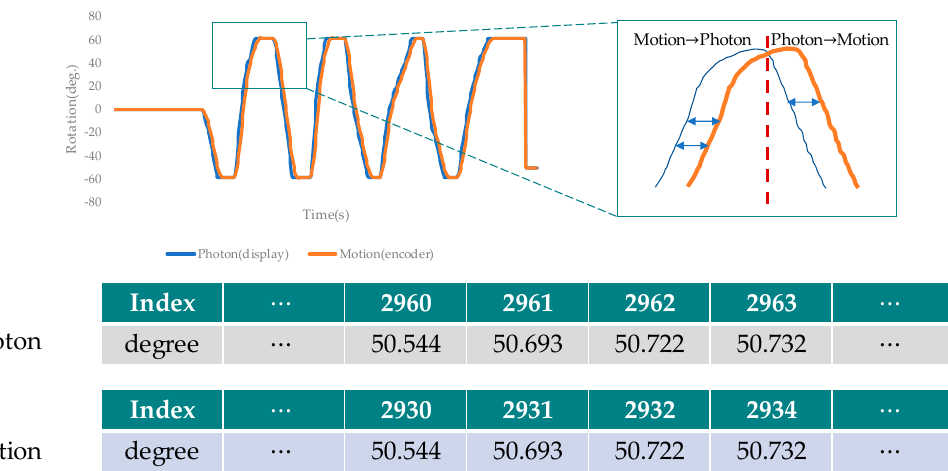
Figure 8. Example of the motion-to-photon latency calculation.